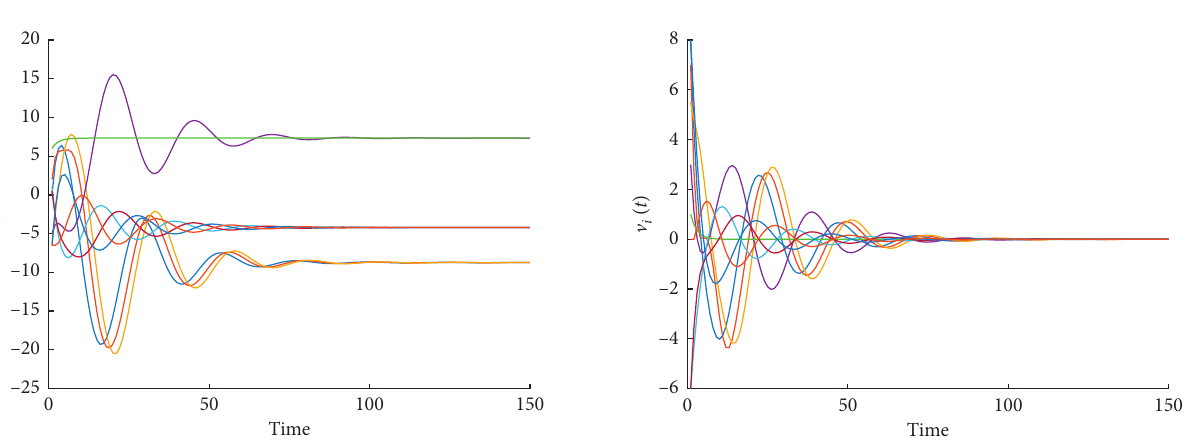
Figure 1: Stationary multiconsensus: positions of agents. Figure 2: Stationary multiconsensus: velocities of agents.